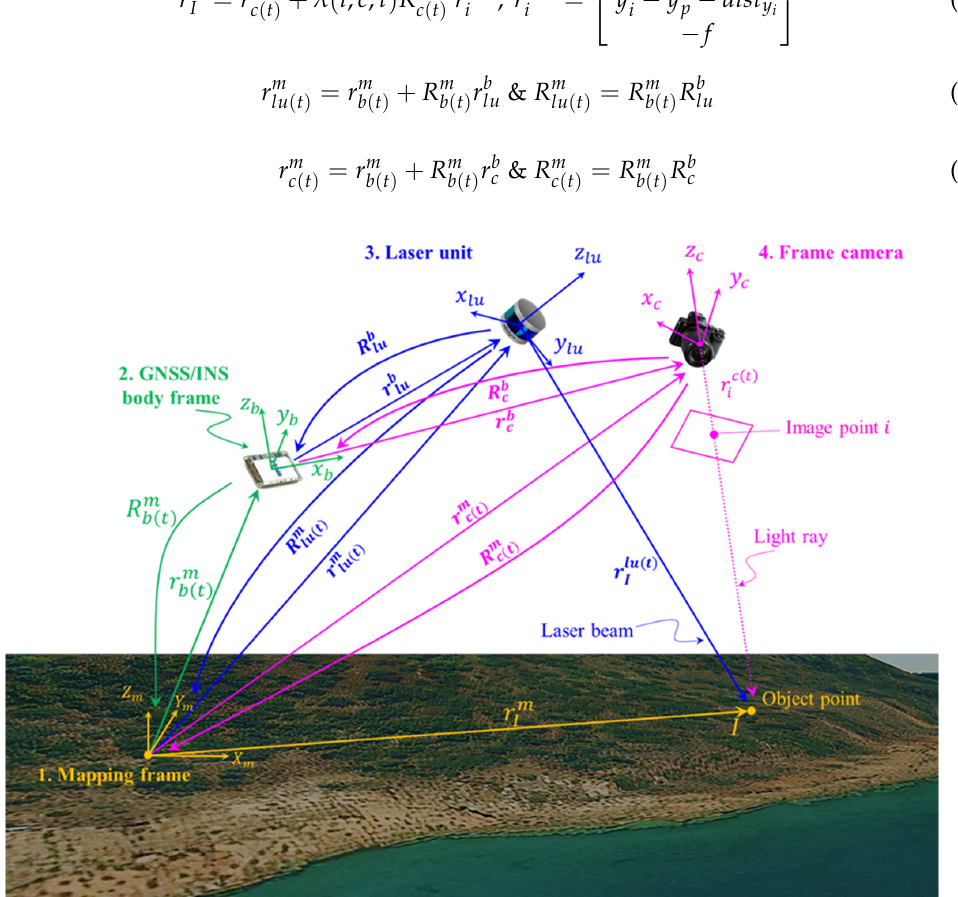
Figure 5. Schematic diagram of the point positioning equations for LiDAR and camera units onboard a GNSS/INS-assisted UAV system.